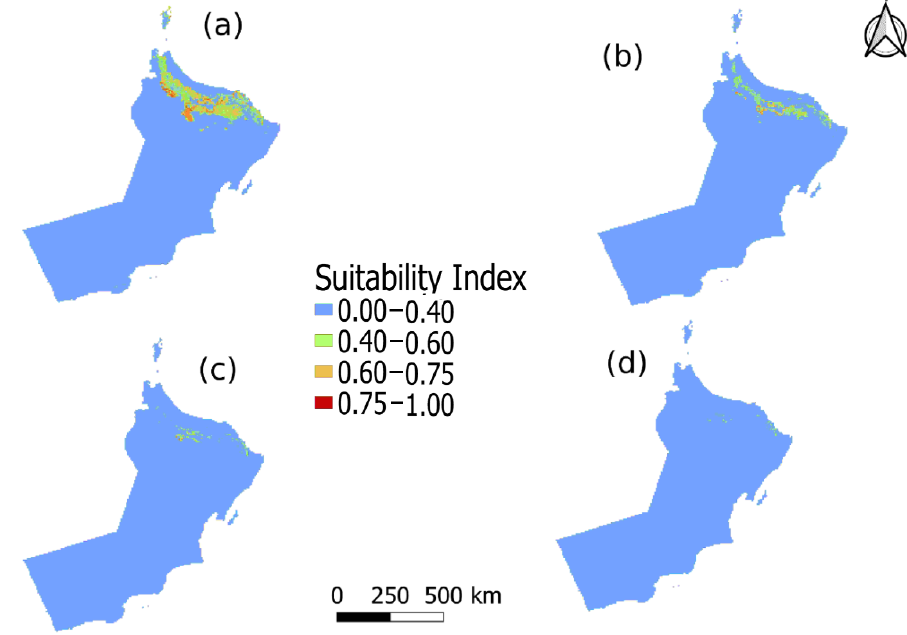
Figure 4. Potentially suitable climatic distribution of 16SrII-D phytoplasma under different climate-change scenarios in Oman for ( a ) 2021–2040, ( b ) 2041–2060, ( c ) 2061–2080, and ( d )